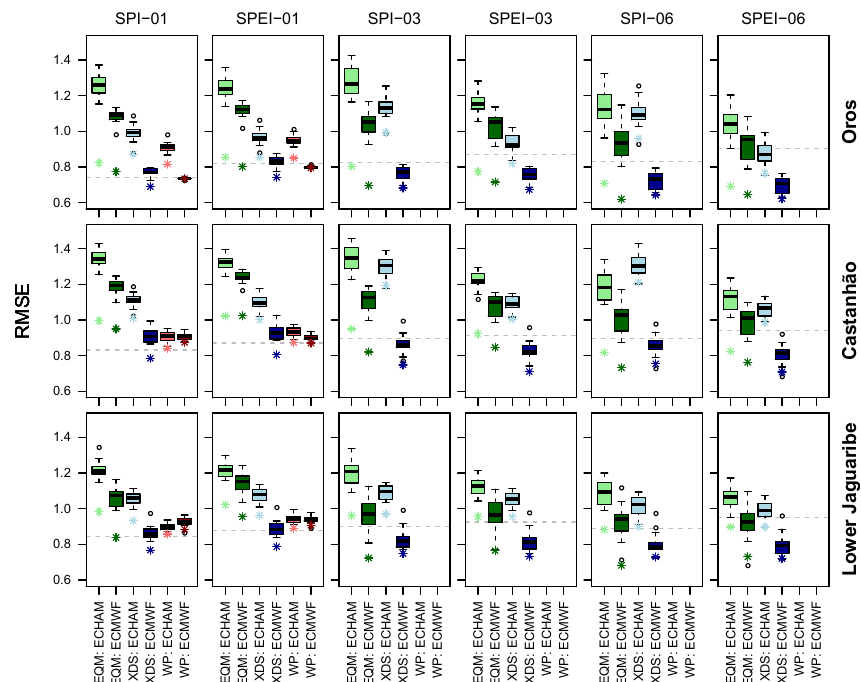
Figure 7. Box plots of the root mean square error of a forecasted meteorological drought index. The asterisk (*) shows the RMSE of the ensemble mean and box plots show the spread of the individual members. Note that in general the ensemble mean ranks better than the best of the ensemble members.